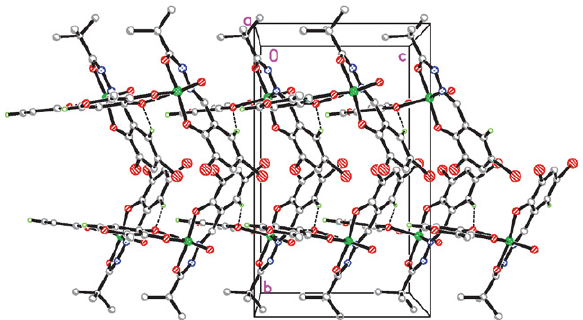
Fig. 4. Molecular packing structure of complex 2 linked by hydro- gen bonds (dashed lines).